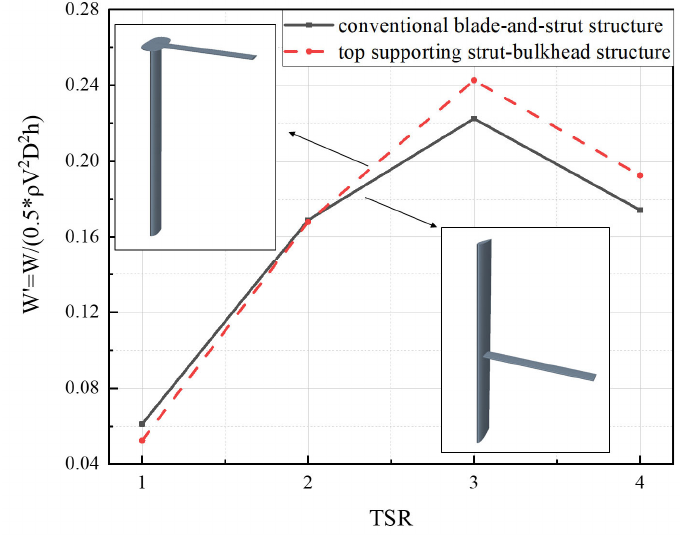
Figure 24. Work done by torque of the whole structure under four TSRs.